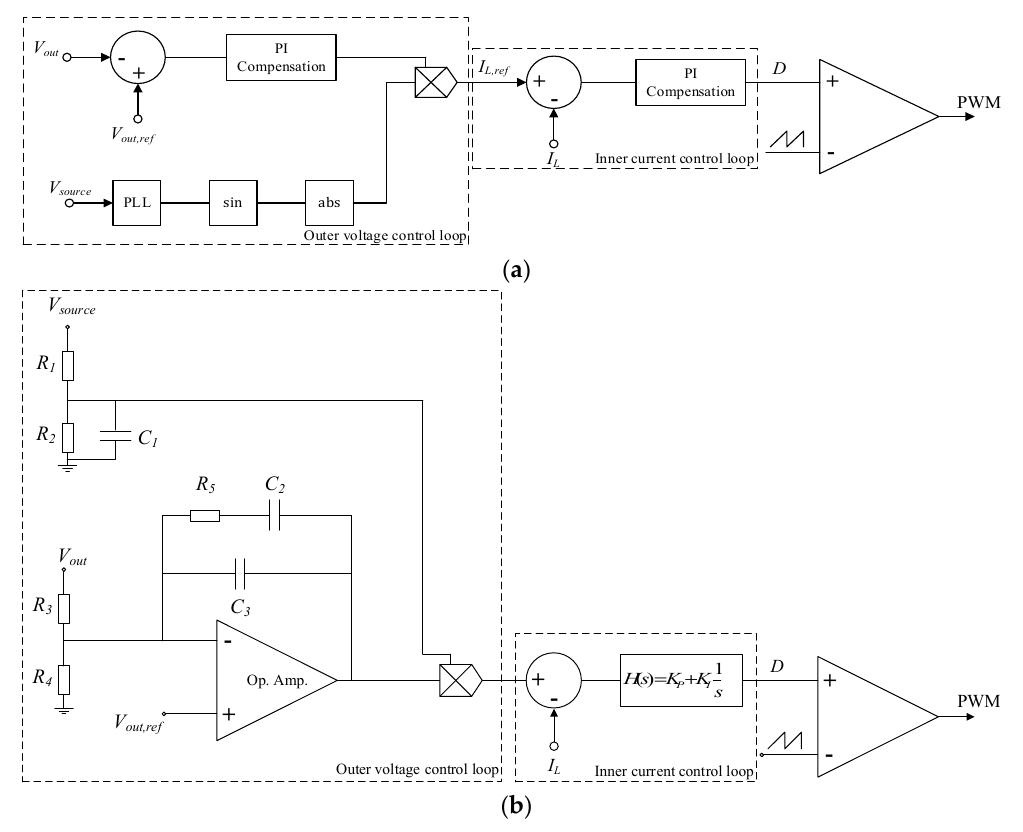
Figure 4. Boost PFC controller. ( a ) Block diagram. ( b ) Circuit.